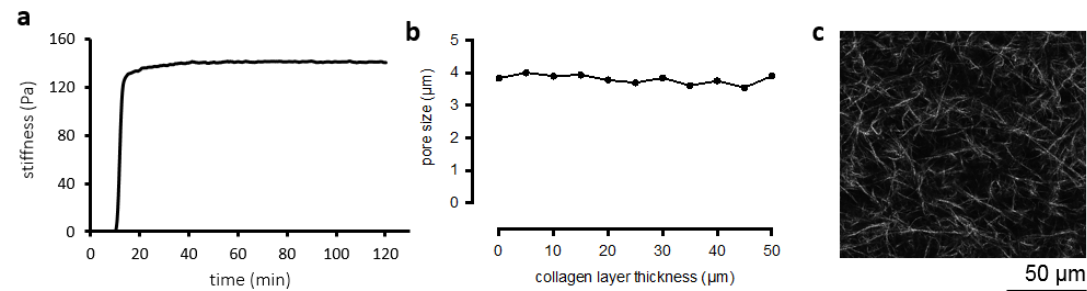
Figure 2. Collagen hydrogel characterization. ( a ) The stiffness (Young’s modulus) of collagen matrices versus time of hydrogel gelation. When the hydrogel is incubated at 37 °C, the hydrogel starts to polymerize, and the stiffness increases gradually until it reaches a plateau. ( b ) Pore size versus collagen layer thickness. The pore size is almost the same in all collagen layers indicating homogeneity of the hydrogel. ( c ) Confocal image of a fluorescently labelled collagen network.